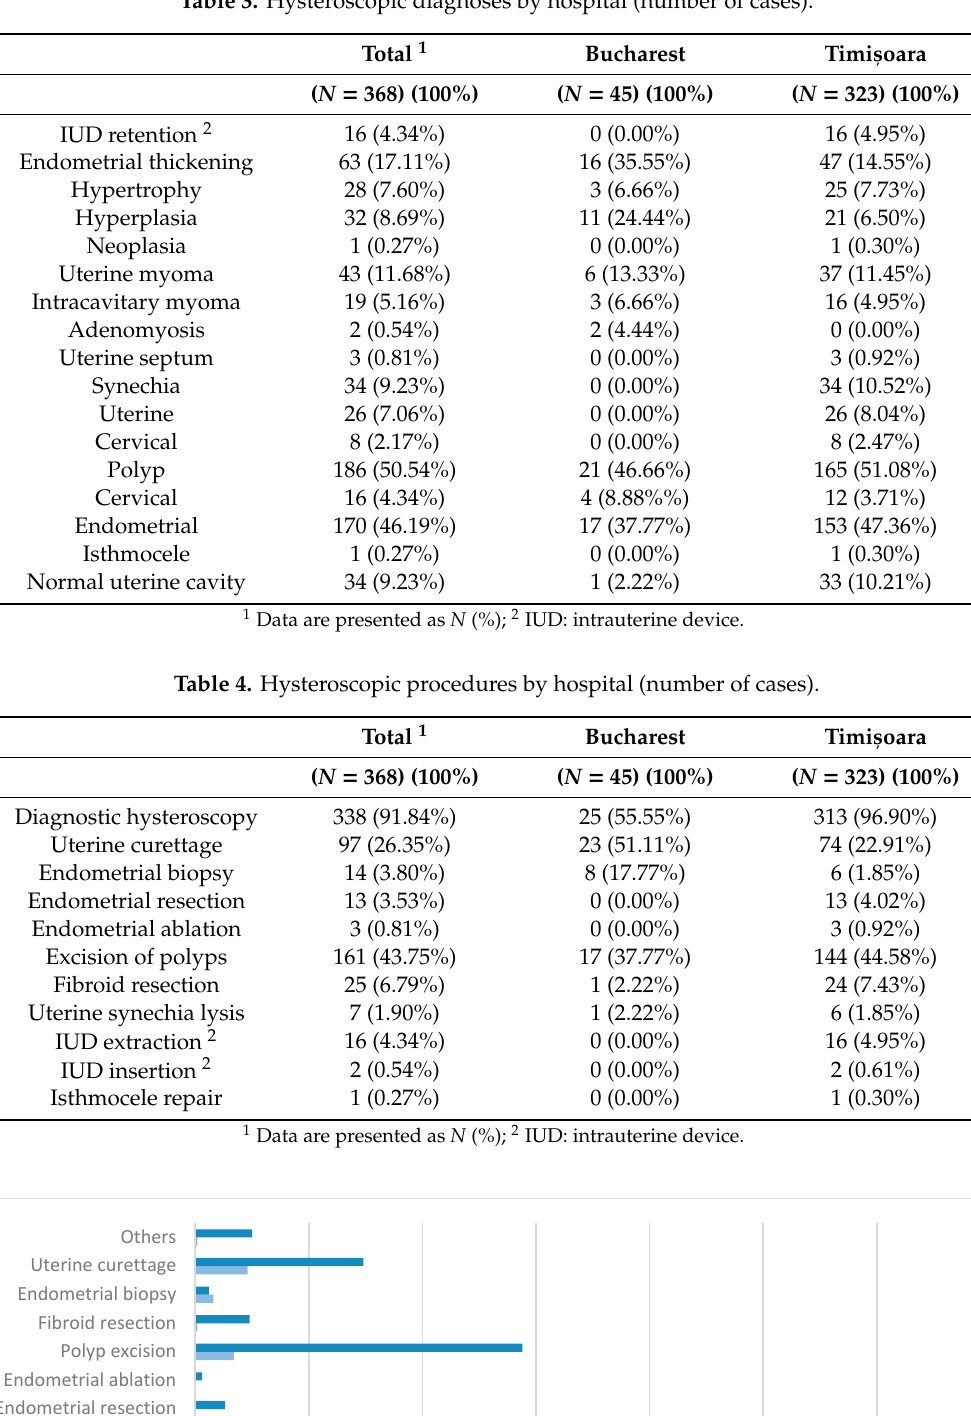
Table 3. Hysteroscopic diagnoses by hospital (number of cases).